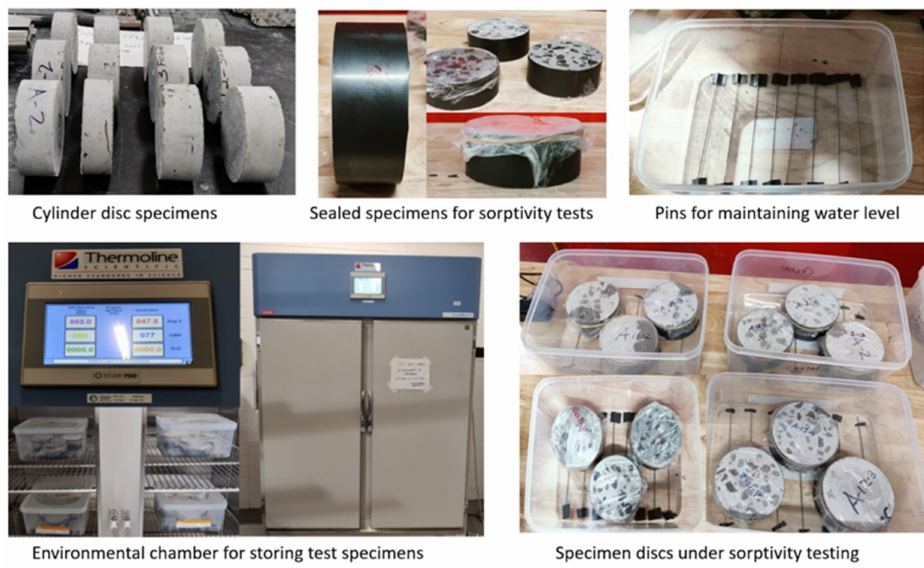
Figure 3. Sorptivity test set-up and test